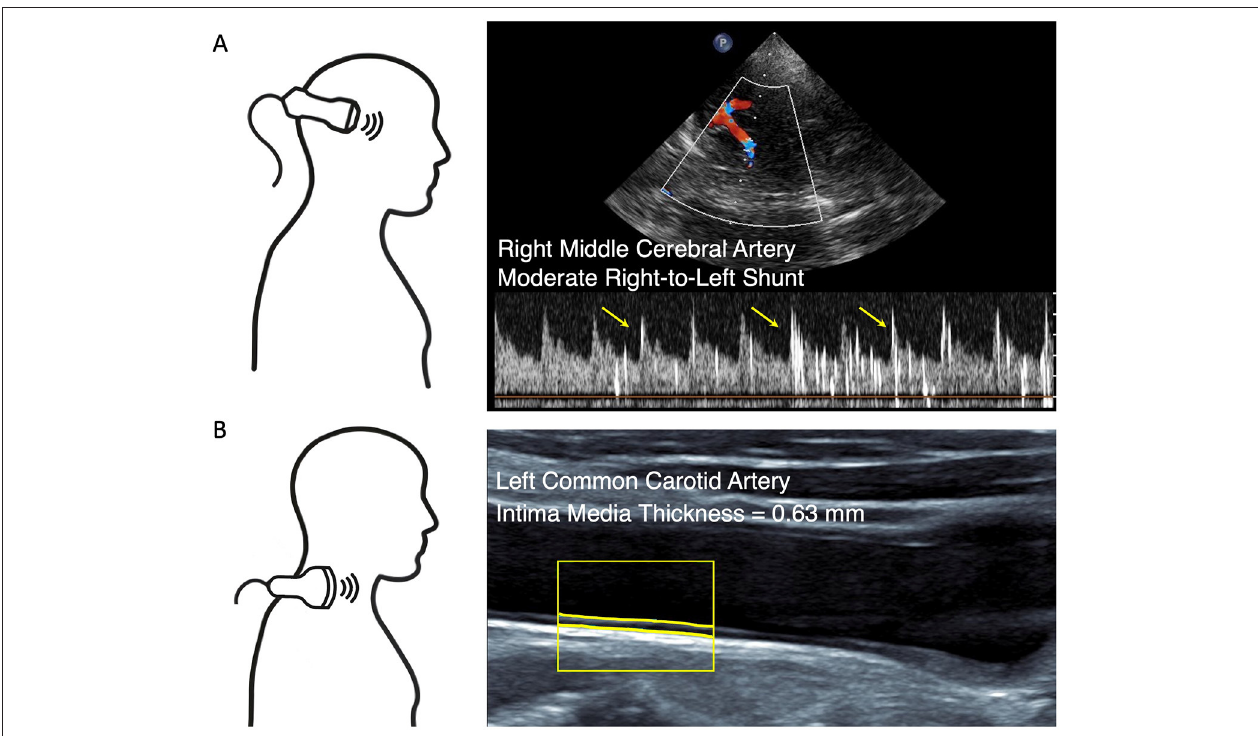
FIGURE 1 | Non-invasive ultrasound. (A) Transcranial Doppler (TCD) bubble test at rest. Duplex-guided Doppler velocity spectrum of the right middle cerebral artery reveals moderate right-to-left shunt within 14s after the injection of agitated saline. Yellow arrows point to exemplary high-intensity signals. (B) Carotid ultrasound with software delineation of the intima media complex reveals normal intima media thickness (IMT).